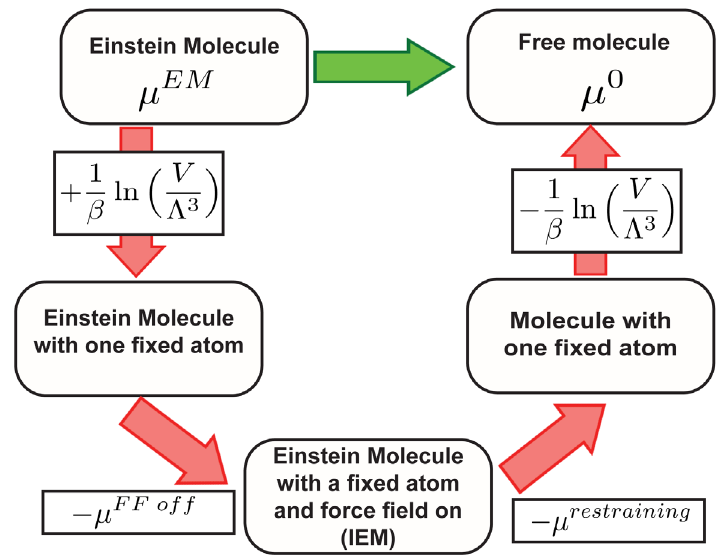
Figure 2. Thermodynamic cycle used to calculate the standard chemical potential of a molecule. Notice its similarity to Figure 1b.